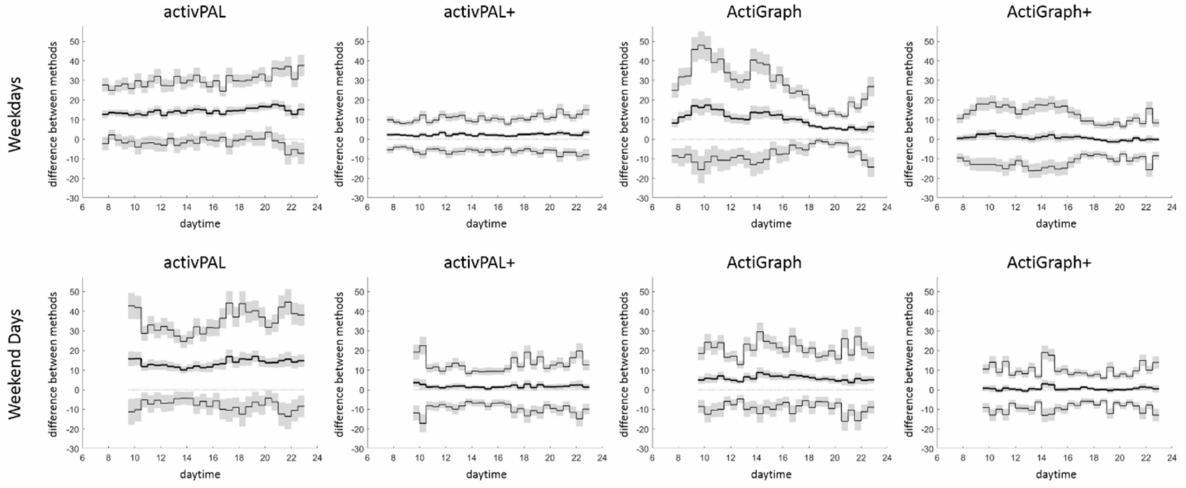
Figure 3. Bias (bold line) and 95% limits of agreement (thin lines) for total sedentary time over 30-min intervals throughout weekdays and weekend days, with 95% confidence intervals (in grey). The data are presented as per cent of the interval length (100% equals 30 min) and shown for intervals with valid wear-time of ≥ 50 participants, i.e., 07:30–23:00 for weekdays and 09:30–23:00 for weekend